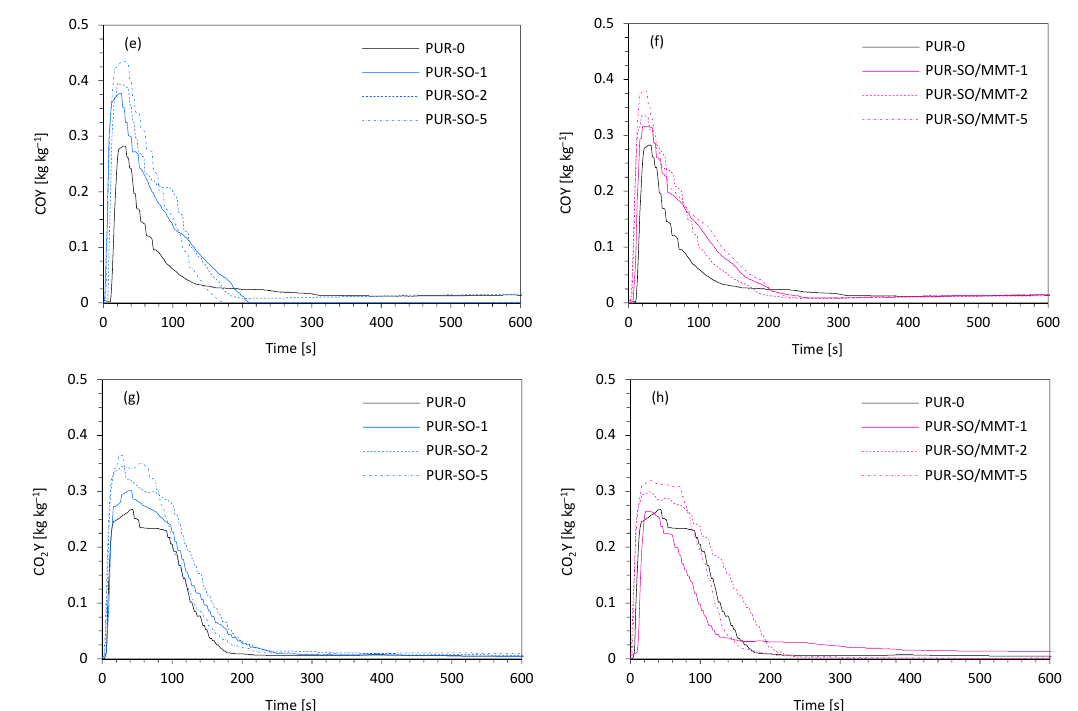
Figure 13. The results of the cone calorimeter test—( a , b ) the peak rate of heat release (pHRR), ( c , d ) the total smoke release (TSR), ( e , f ) the average yield of CO, and ( g , h ) the average yield of CO 2 .